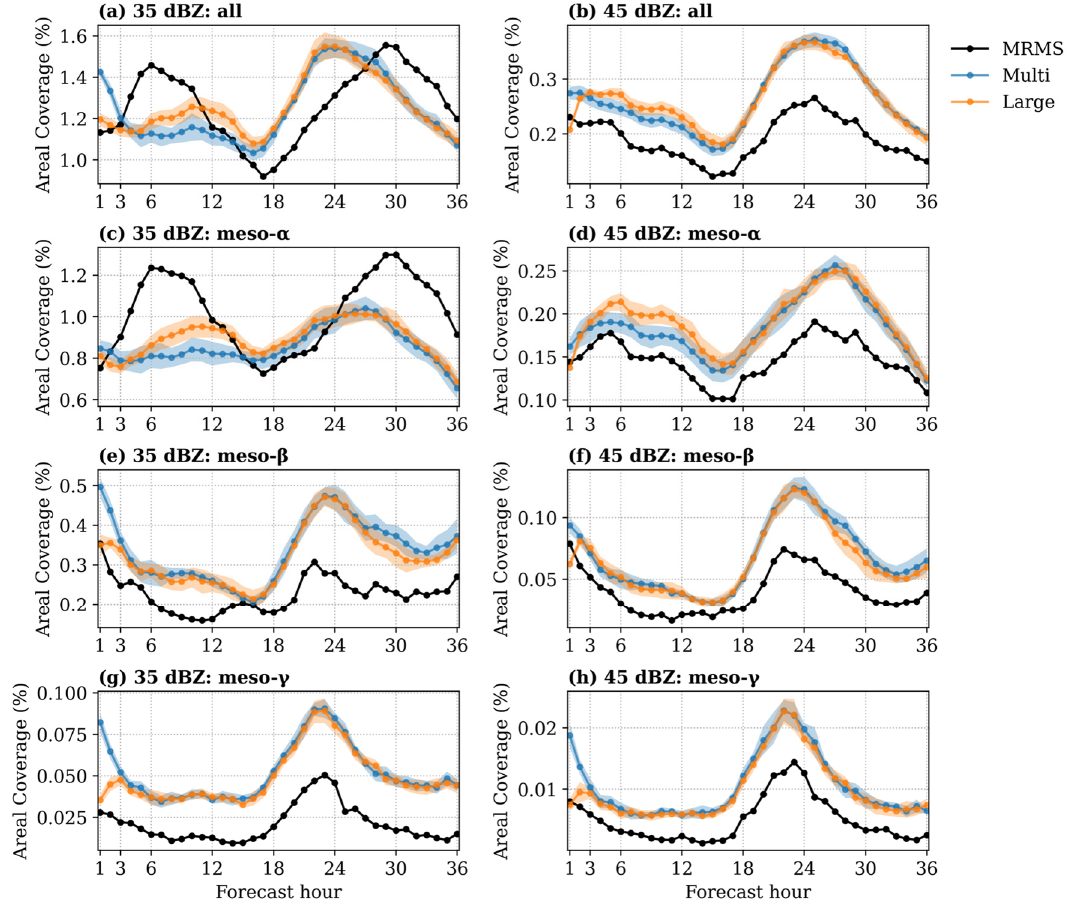
Figure 6. Forecast and MRMS areal coverage (%) over the verification domain for (first row) the full field, (2 nd –4 th row) meso-alpha, meso-beta, and meso-gamma subfields averaged over 25 cases with a 35 dBZ threshold (a, c ,e and g) and a 45 dBZ threshold (b, d, f and h). Blue and orange dotted lines represent ensemble mean areal coverage for MULTI and LARGE, respectively, with shades representing one standard deviation range among ensemble members.